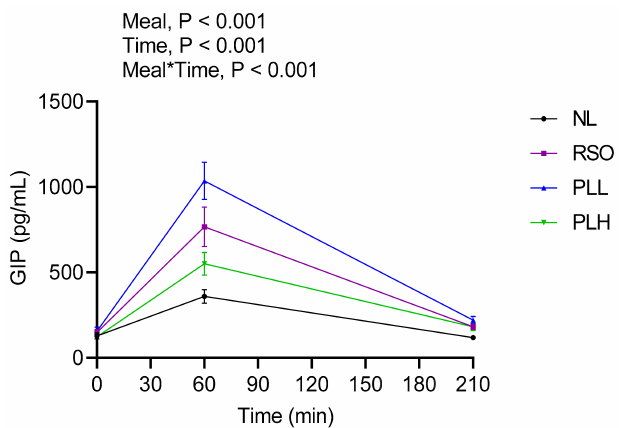
Figure 9. Mean concentrations of GIP after intake of test meals at breakfast. Values are means ± SEM, n = 18 healthy subjects. Repeated measures; mixed model in SAS. NL, oat preparation without added lipids; RSO, oat preparation added with rapeseed oil; PLL, oat preparation with a low concentration of polar lipids; PLH, oat preparation with a high concentration of polar